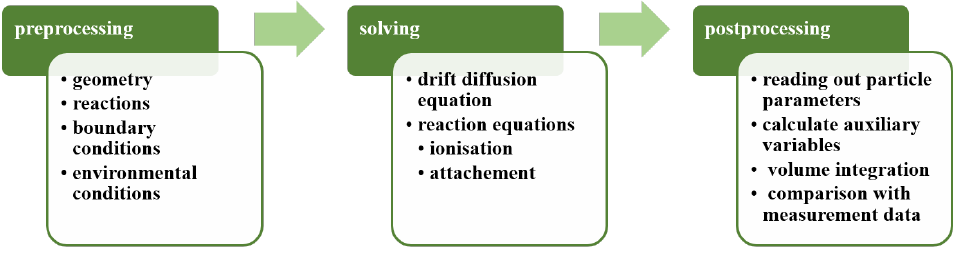
Figure 1. Scheme for the methodical procedure of the modeling of a partial discharge